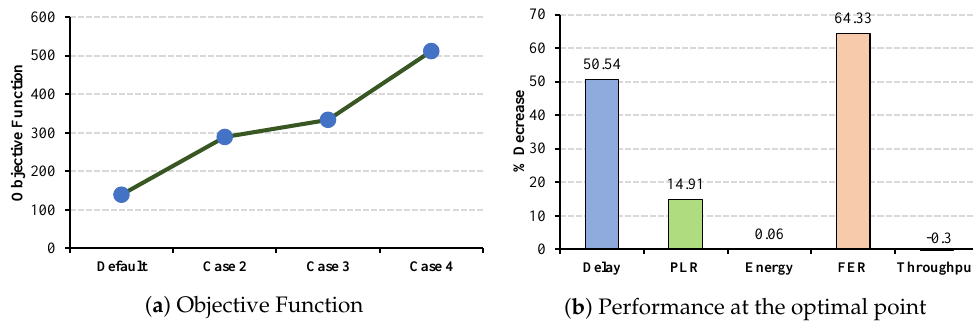
( b ) Performance at the optimal point Figure 16. EMR QoS metrics and energy consumption under CW changes for slave